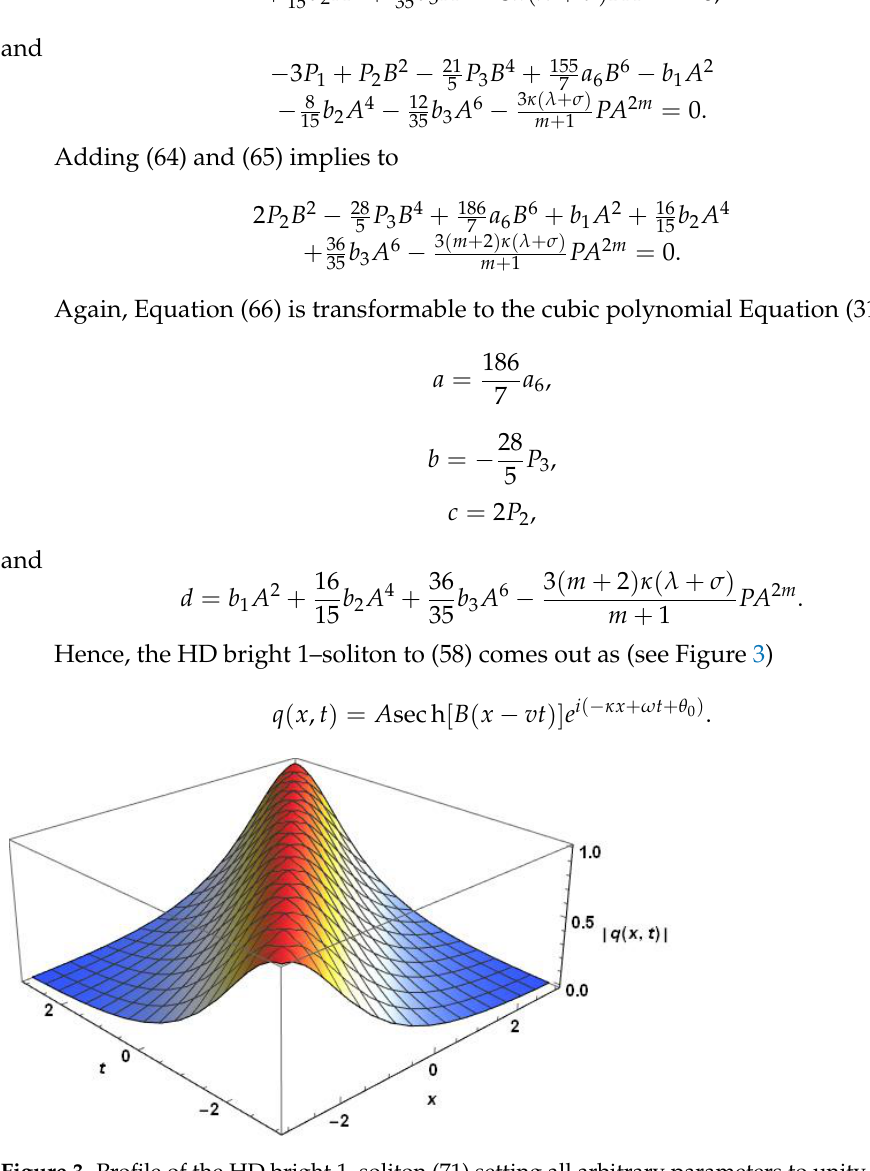
Figure 3. Profile of the HD bright 1 – soliton (71) setting all arbitrary parameters to